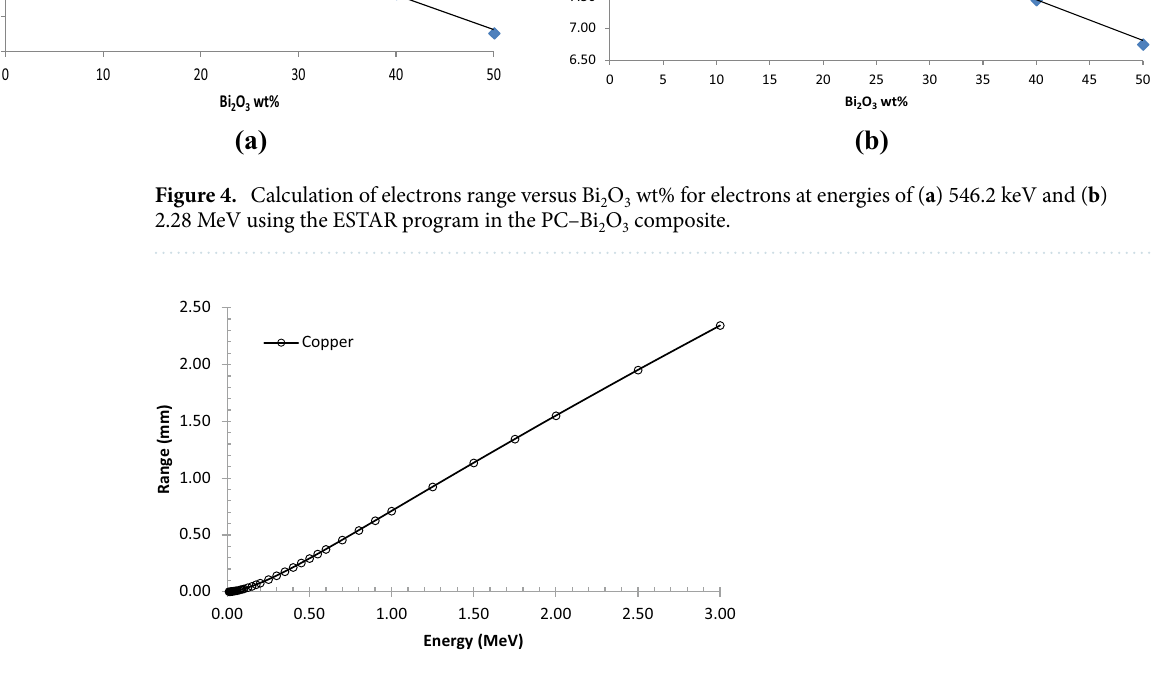
Figure 5. Calculation of the range for electrons at various energies up to 3 MeV in the copper using the ESTAR